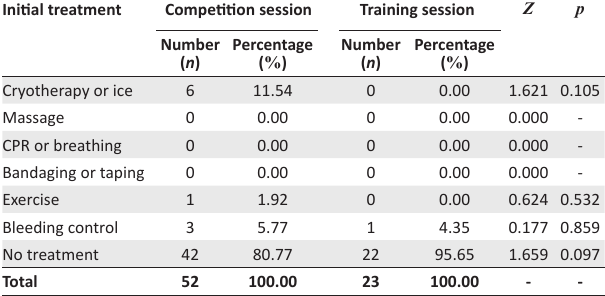
TABLE 6: Treatment received during competition and